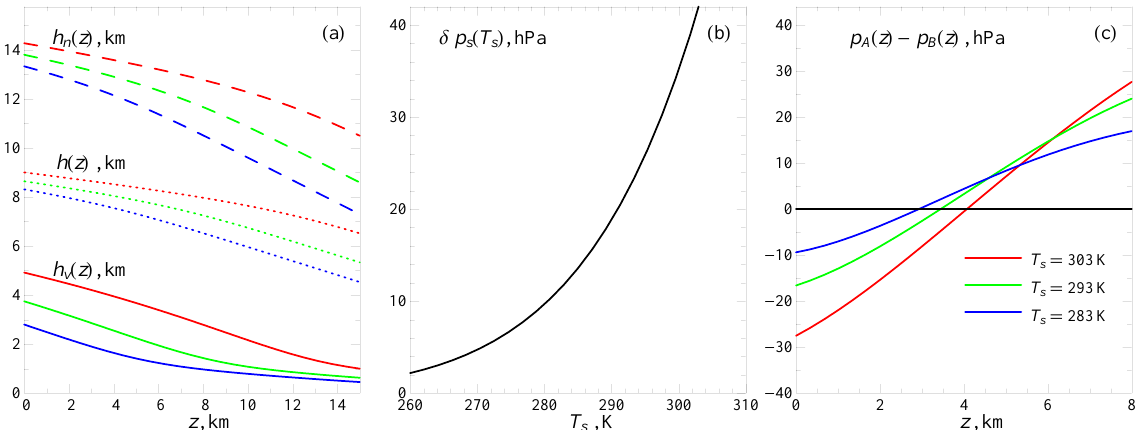
Fig. 1. (a) Scale height of saturated water vapor h v (z) (Eq. 24), hydrostatic scale height of water vapor h n (z) (Eq. 26), and scale height of moist air h(z) (Eq. 20) in the column with moist adiabatic lapse rate (Eq. 22) for three values of surface temperature T s ; (b) condensation- induced drop of air pressure at the surface (Eq. 27) as dependent on surface temperature T s ; (c) pressure difference versus altitude z between atmospheric columns A and B with moist and dry adiabatic lapse rates, Eqs. (30) and (31), respectively, for three values of surface temperature T s . Height z c at which p A (z c ) − p B (z c ) = 0 is 2.9, 3.4 and 4.1km for 283, 293 and 303K, respectively. Due to condensation, at altitudes below z c the air pressure is lower in column A despite it being warmer than column